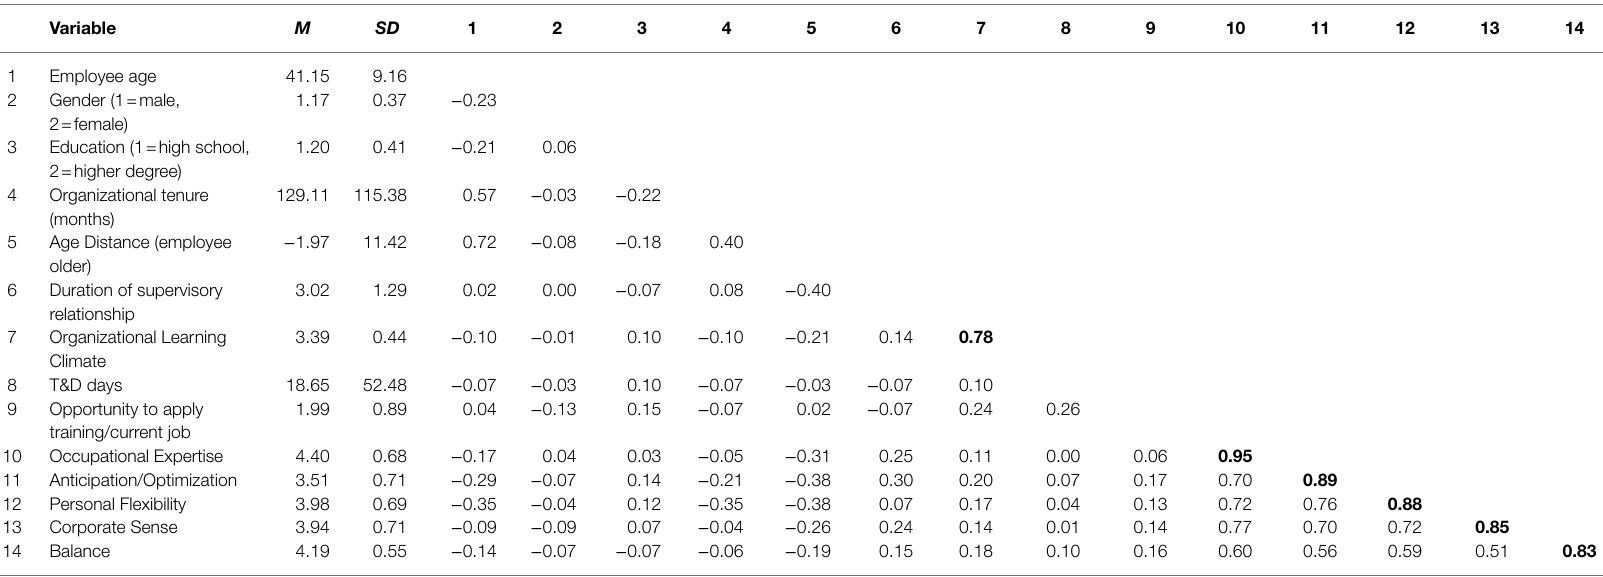
TABLE 1 | Means, standard deviations and inter-correlations between study